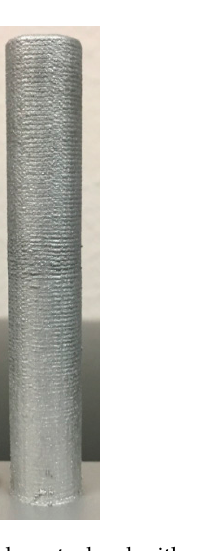
Figure 1. Macroscopic view of a 17-4 PH stainless steel rod with an approximate diameter of 1.27 cm and height of 8.18 cm that was printed by LENS.